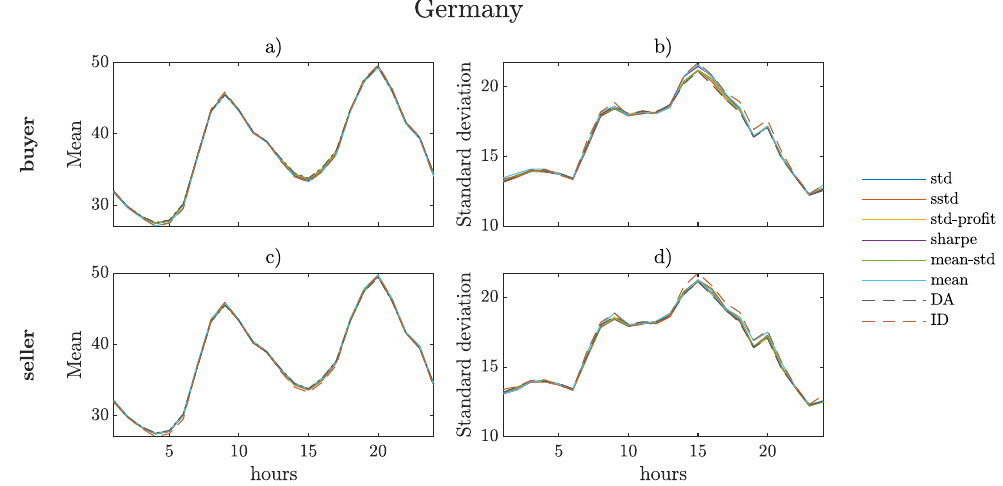
Figure 5. Means (for buyer—panel ( a ) and for seller—panel ( c )) as well as standard deviations (for buyer—panel ( b ) and for seller—panel ( d )) of hourly prices in the validation window obtained from different strategies in the German market. For reference, also the results of trading only on the day-ahead (DA) or intraday (ID) market are plotted with dashed lines.Source: Authors’ elaboration.